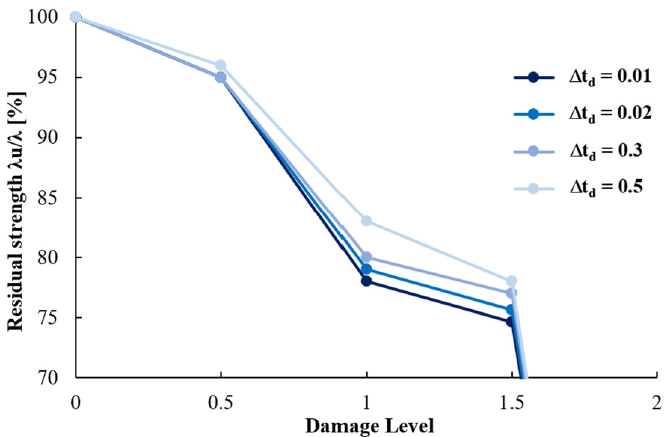
Figure A4. Pushover curve of 2D RC frame structure—damage level 1: effect of variation of ∆ t d (removal time of the column). ∆ t d values are expressed in seconds.